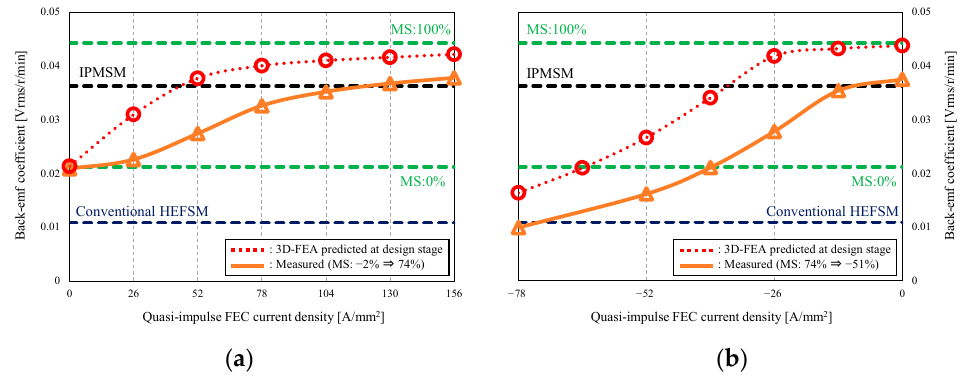
Figure 12. Measured and 3D-FEA predicted back-emf coefficient curves. ( a ) MS strengthening region; ( b ) MS weakening region.